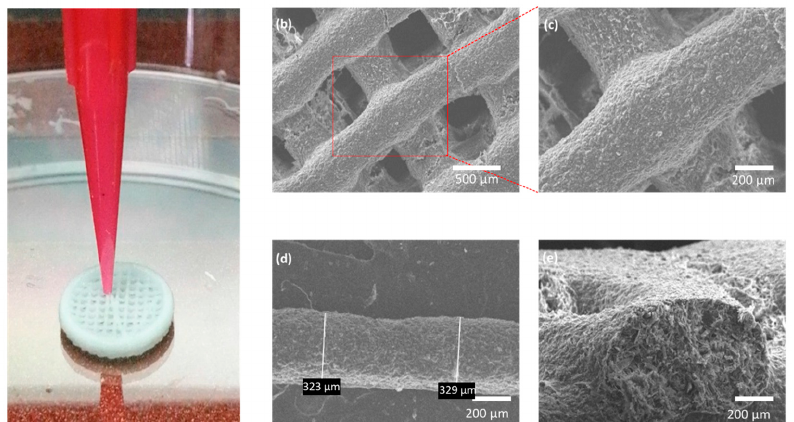
Figure 6. A picture of a representative 3D printed scaffold with the Alg_MCC 40 ink ( a ) and SEM images for this scaffold: ( b ) Top ‐ view, ( c ) zoom ‐ in of the area marked with the red rectangle, ( d ) single printed filament with measurements, ( e ) cross ‐ section of printed mat filament.